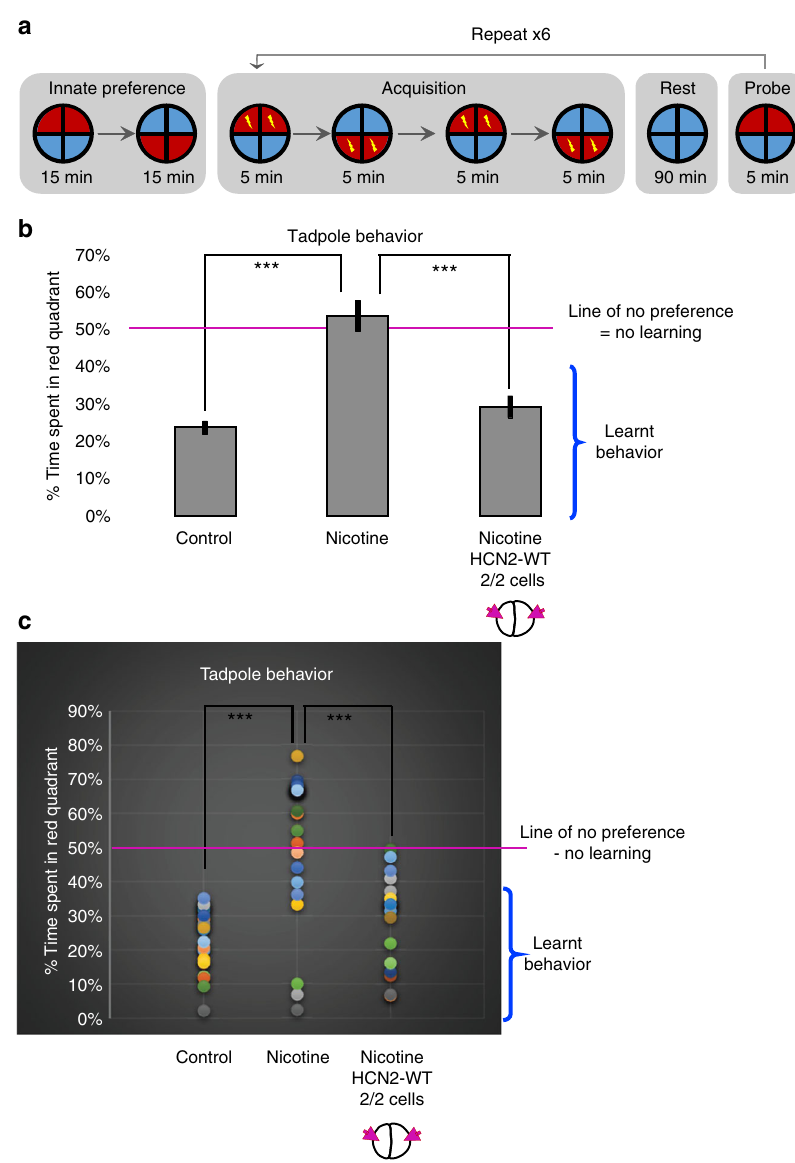
Fig. 7 HCN2 channels restore associative learning capacity in nicotine-exposed embryos. Associative learning capacity analysis for stage 45 – 50 tadpoles either left untreated (controls) or exposed to nicotine (0.1 mg/mL – stage 10 – 35) with or without microinjections of Hcn2-WT mRNA (0.75 ng/injection) in both blastomeres at 2-cell stage as indicated in the illustrations. a The training regime used consisted of an innate preference test, a training phase, a rest period, and a learning probe. Tadpoles were placed individually in the behavior analysis robot. Motion tracking cameras under each tadpole recorded its position/behavior, and automated software executed a training cycle where animals received a shock when occupying the red half of the arena. Training, rest and testing sessions were repeated a total of six times across the trial. b Quanti fi cation of time spent in the red color during the fi nal testing probe for tadpoles in each treatment group. N > 20 for each experimental group. Error bars indicate ± S.E.M. Data were analyzed using one way ANOVA *** p < 0.001. c Representation of individual tadpole ’ s associative learning test. N > 20 for each experimental group. Following the training sessions a signi fi cant red light aversion was generated in control tadpoles. Majority of nicotine-exposed tadpoles failed to demonstrate red light aversion learning during testing. Nicotine- exposed tadpoles microinjected with Hcn2-WT mRNA showed a restored ability to learn associative red light